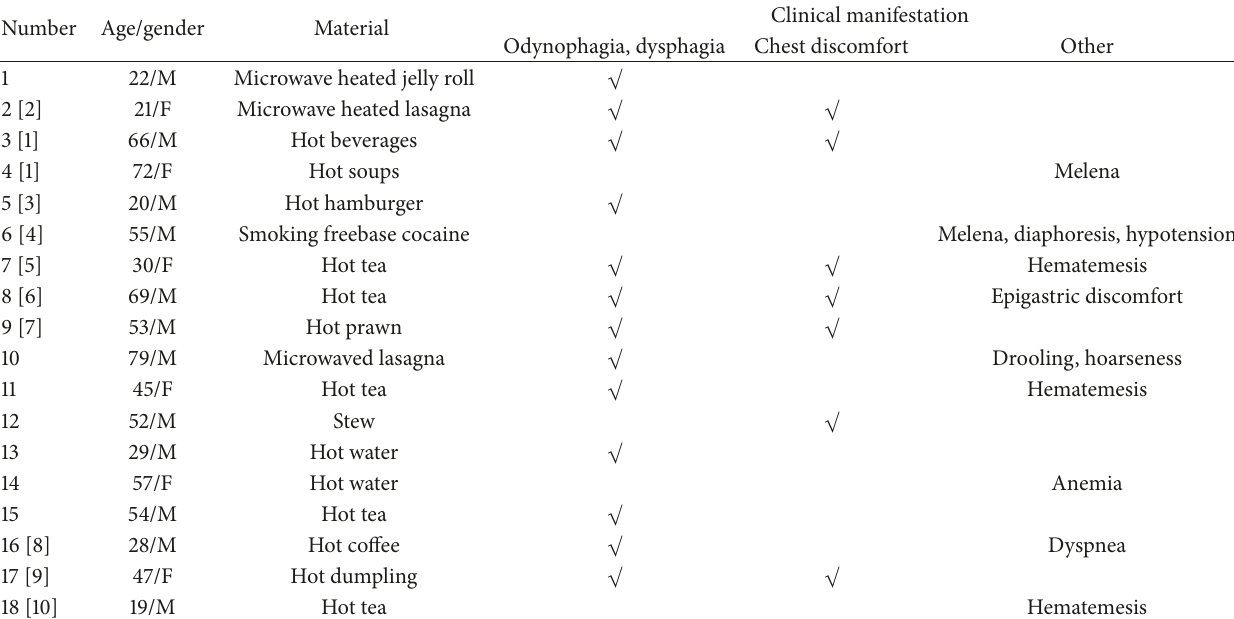
Table 1: Summary of clinical manifestation in ETI published cases.